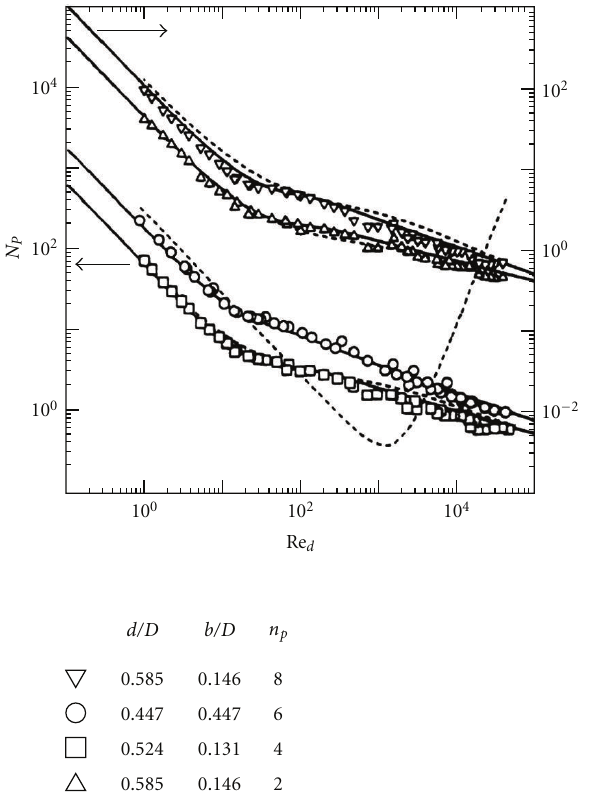
Figure 4: Power diagram of paddle impeller (--- [3]; — [4, 5]).